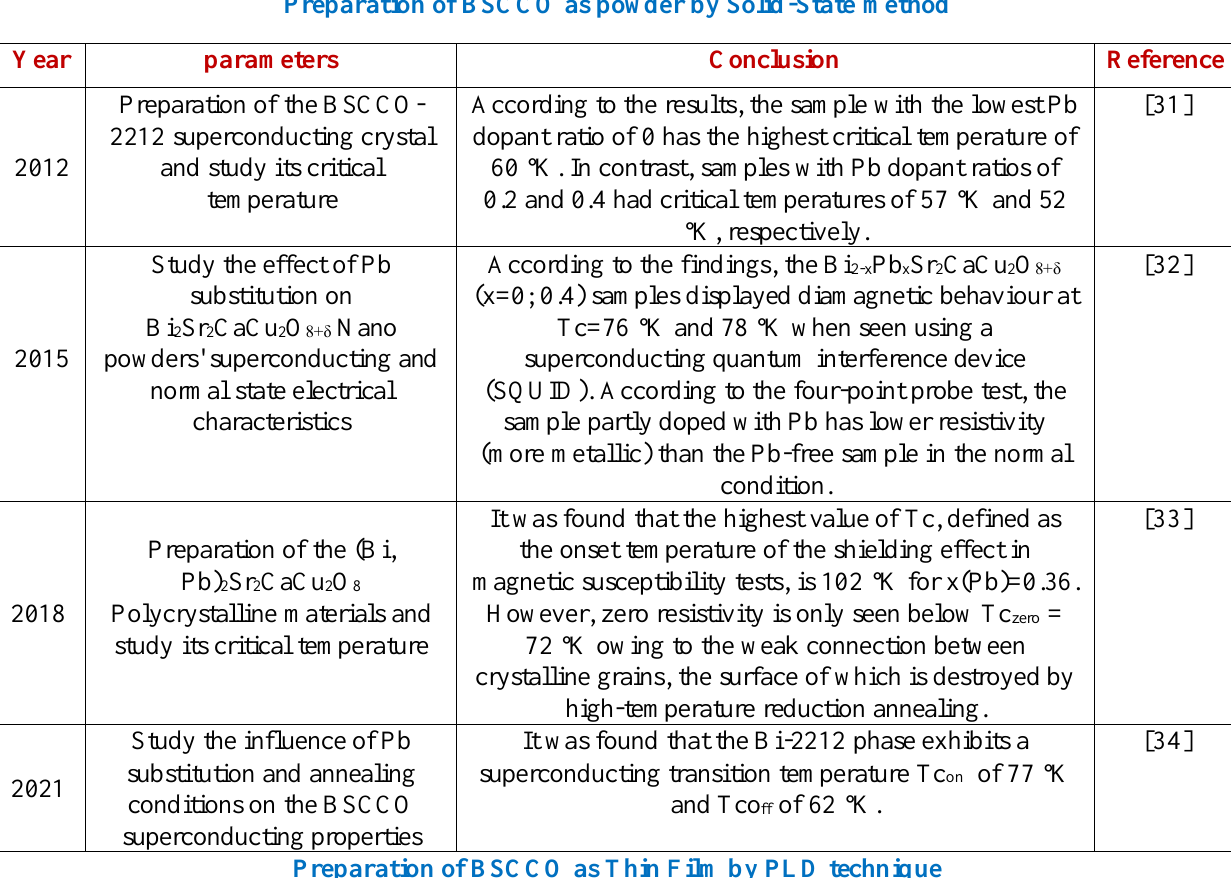
Table 1: Presents some recent studies on the BSCCO compound and its preparation as powder and thin film. Preparation of BSCCO as powder by Solid-State